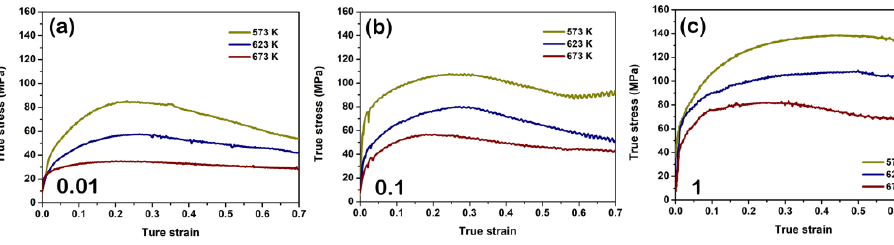
Figure 4. ( a ) Peak stresses and ( b ) peak strains at different deformation conditions. Note that the color difference is to better distinguish the size of the value. 3.3. Constitutive Model during Hot Compression The Arrhenius constitutive models are given [34]: 𝜀̇ = 𝐴 1 𝜎 𝑛 1 𝑒𝑥𝑝⁡(− 𝑄 𝑅𝑇)